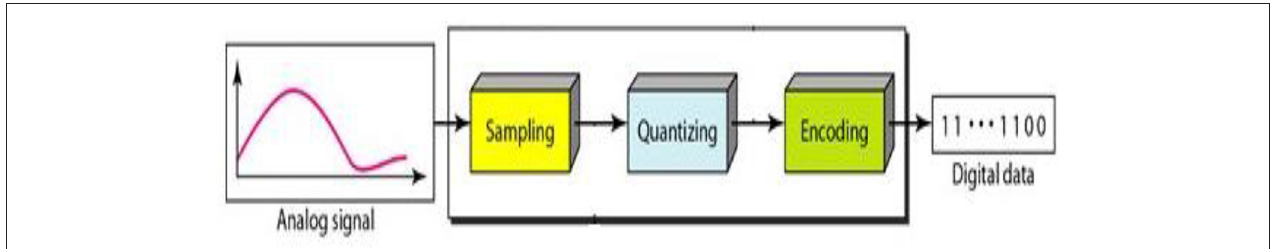
FIGURE 7 | Speech signal